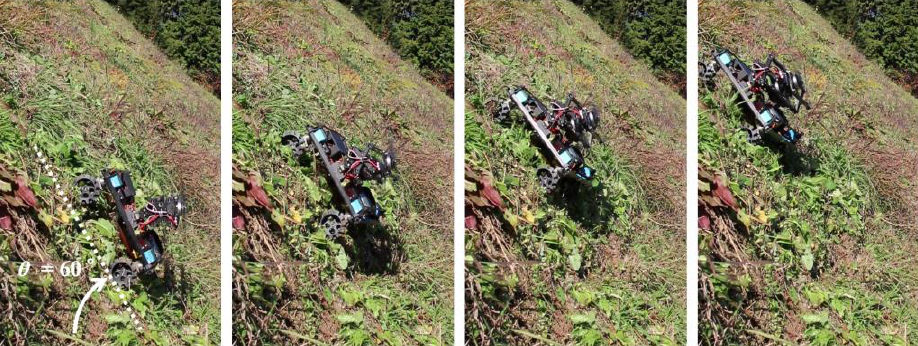
Figure 16. Steep slope climbing.